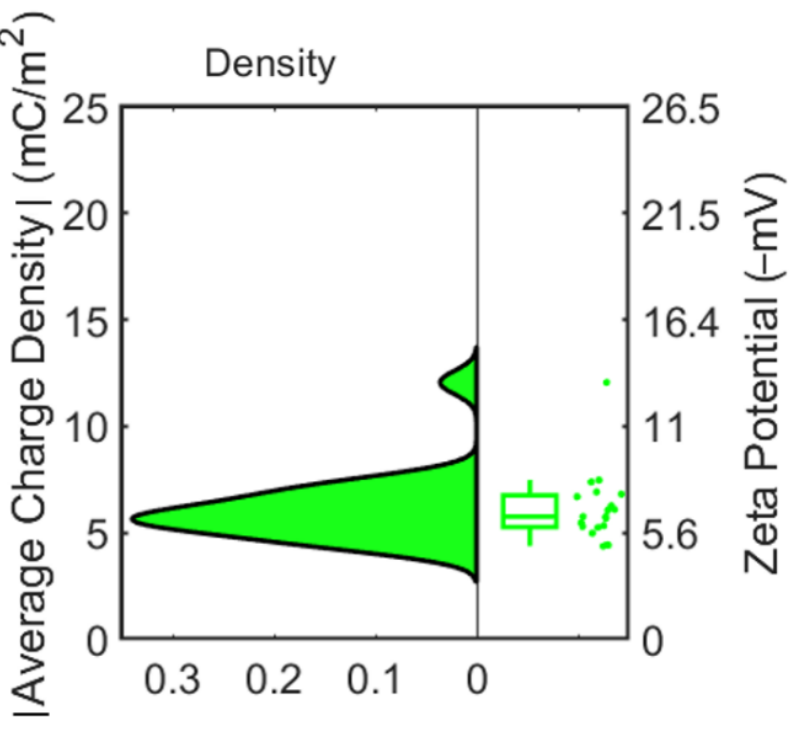
Figure 4. Left: distribution of average charge density of each MP obtained from fluorescence method. Right: boxplot of zeta potential converted from average charge density of MPs.